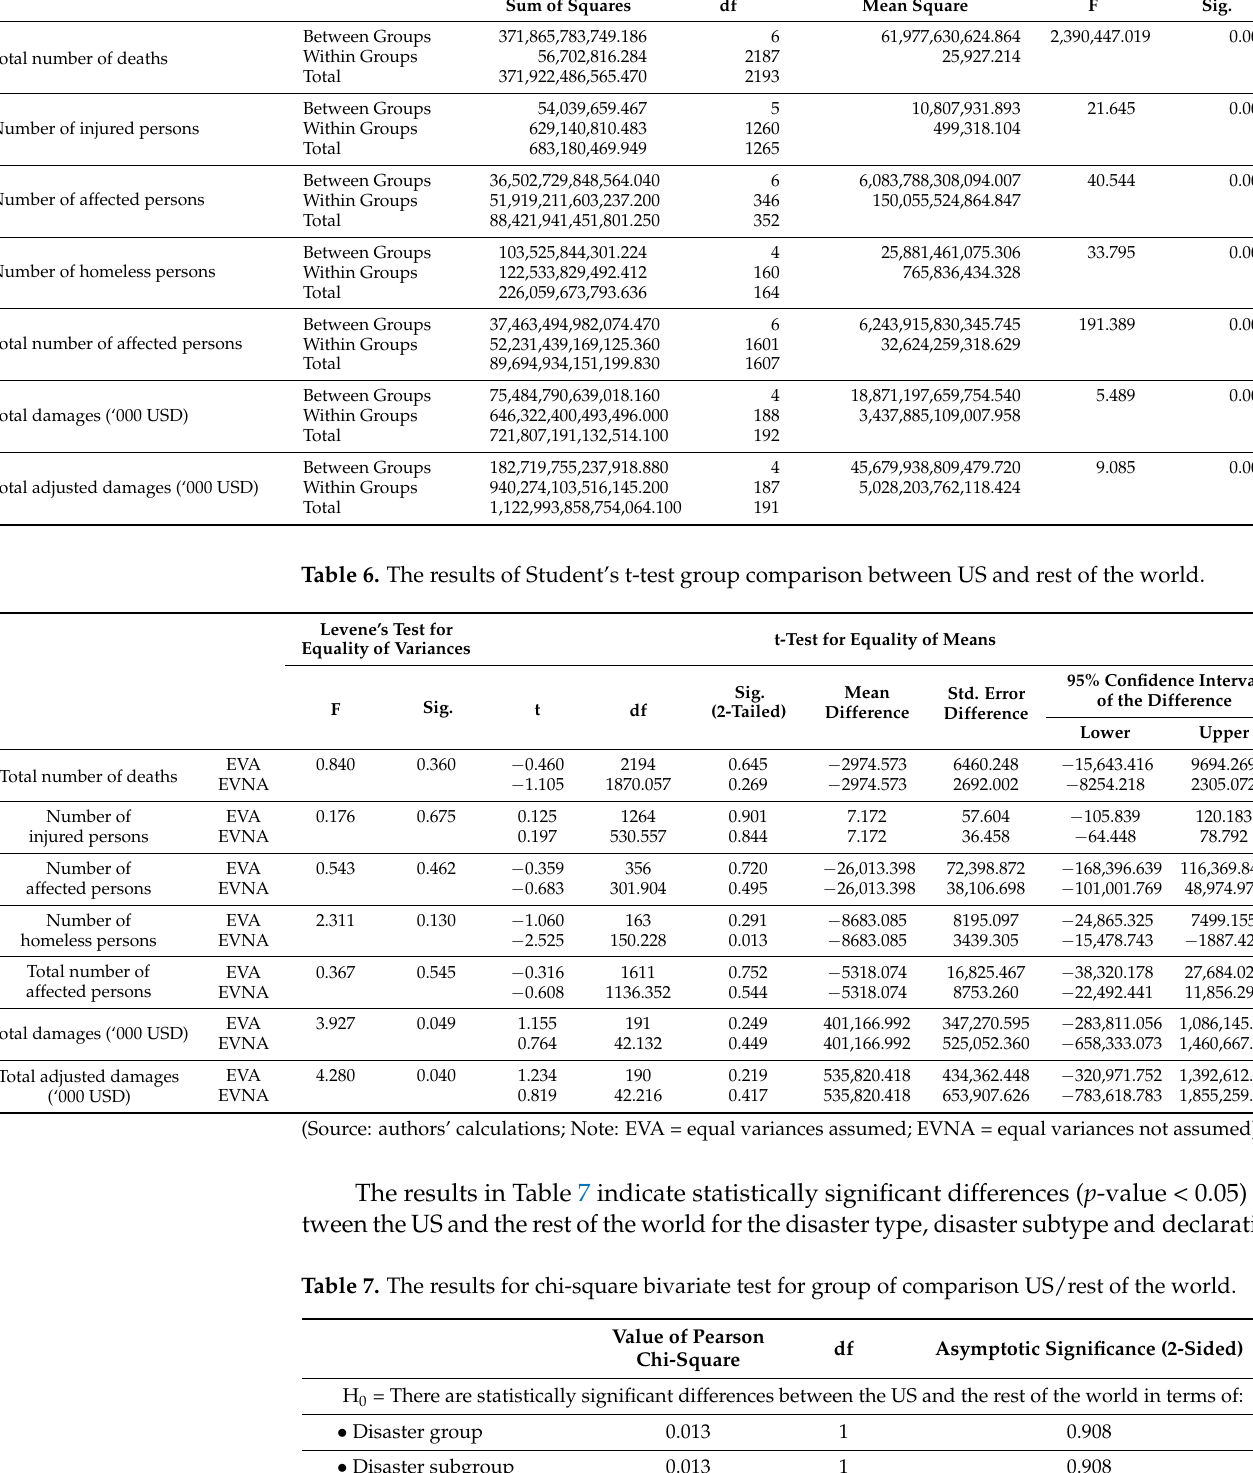
Table 5. The results of One-way ANOVA test for grouping by disaster subtype. Sum of Squares df Mean Square F Sig.